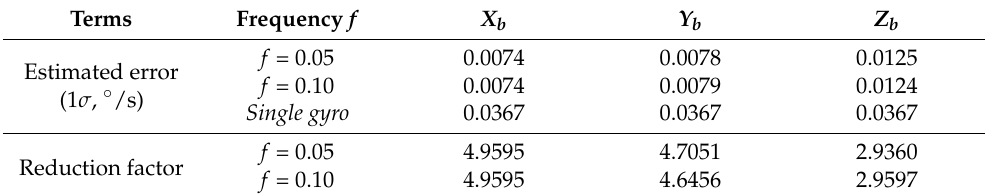
Table 9. The estimated errors (1 σ ) of 4-MIMU for the swing test ( ω z = 5 × sin(2 π ft )).